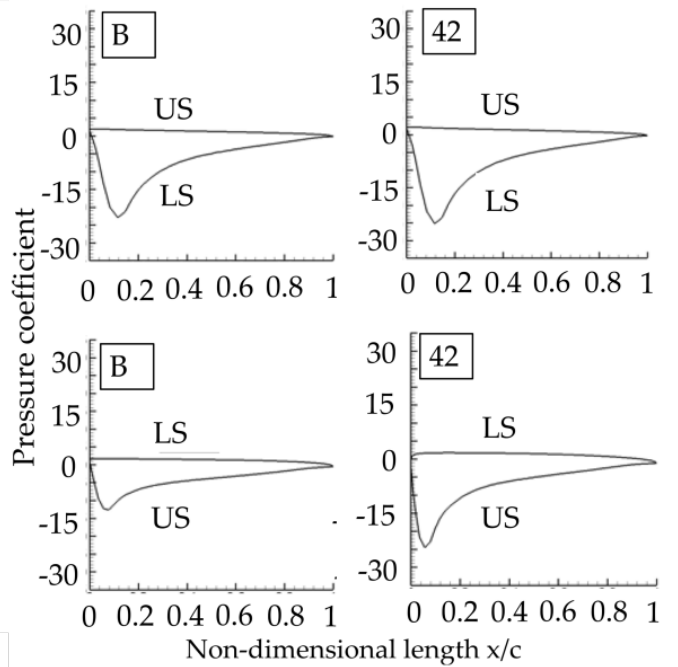
Figure 7. A comparison of the surface pressure distribution between the upstream-deflector hydrofoil and the conventional hydrofoil (first row: t / T = 0.2; second row: t / T = 0.65).